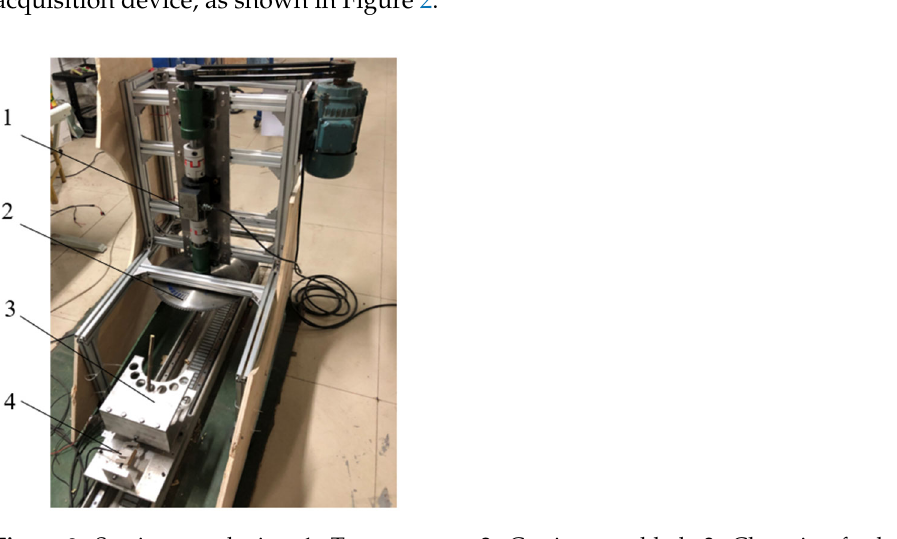
Figure 2. Sawing test device. 1. Torque sensor 2. Cutting saw blade 3. Clamping feed device 4. Tension-compression sensor.